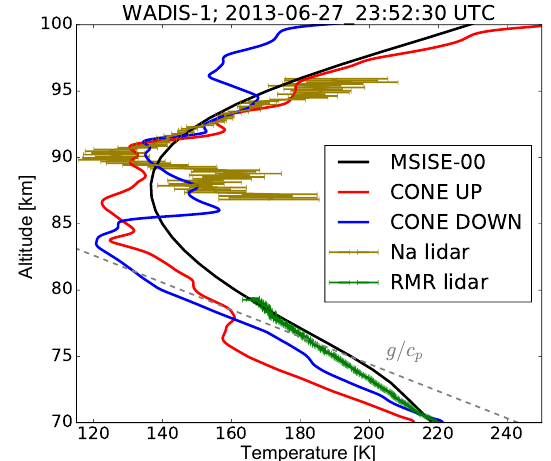
Figure 9. Temperature field measured with RMR (lower part) and Na lidar (upper part) around WADIS-1 sounding rocket launch (27 June 2013, 23:52:30 UTC).